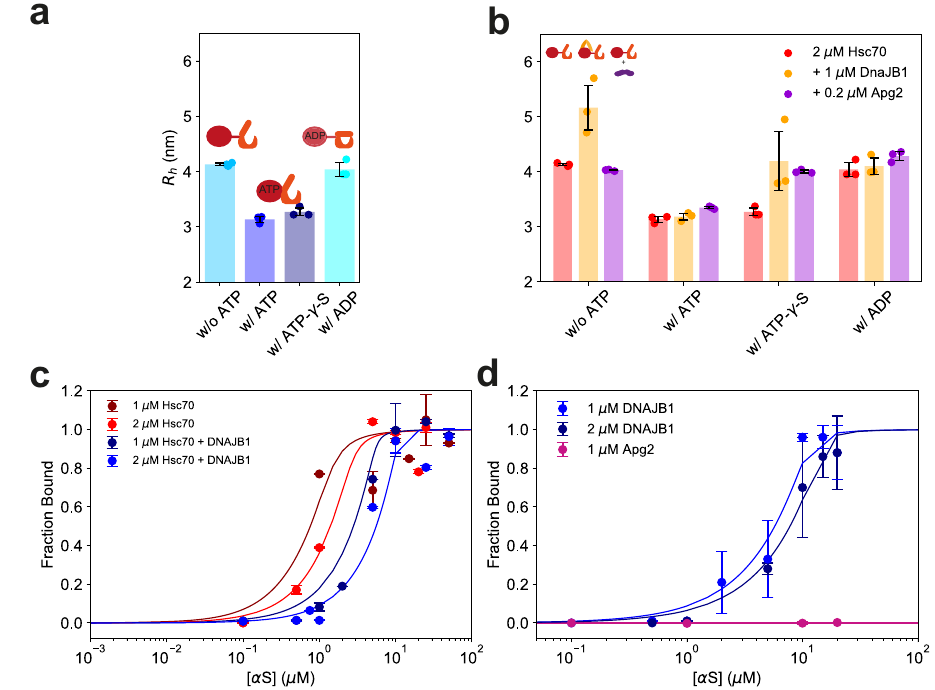
Fig. 5 Characterisation of the binding interaction between chaperones and α S fi brils. a Conformational compaction of fl uorescently labelled Hsc70 upon binding of ATP and ATP γ S, as shown by the change in hydrodynamic radius. Binding to ADP preserves the more expanded state. b Binding interaction between fl uorescently labelled Hsc70 and its co-chaperones. Binding was observed between Hsc70 and DnaJB1, leading to an increase in hydrodynamic radius. DnaJB1 can bind in absence of ATP and in presence of ATP- γ -S but dissociates from Hsc70 in the presence of ATP due to the fast hydrolysis of ATP. c Binding of Hsc70 to α S fi brils. Hsc70 shows a binding af fi nity of K d = 139.0 ± 27.6 nM in the presence of ATP ( R 2 = 0.98) and a tighter af fi nity K = 47.5 ± 16.0 nM in the presence of DnaJB1 ( R 2 = 0.96), which triggers hydrolysis of ATP to ADP, thereby leading to lid closure and stronger binding. d d Binding of DnaJB1 and Apg2 to α S fi brils. Apg2 did not bind to α S fi brils. DnaJB1 bound to α S fi brils with an af fi nity of K d = 246.1 ± 28.1 nM ( R 2 = 0.98). The concentrations of α S are given with respect to monomer equivalents. Data in b – d are represented as mean ± standard deviation of n = 3 independent